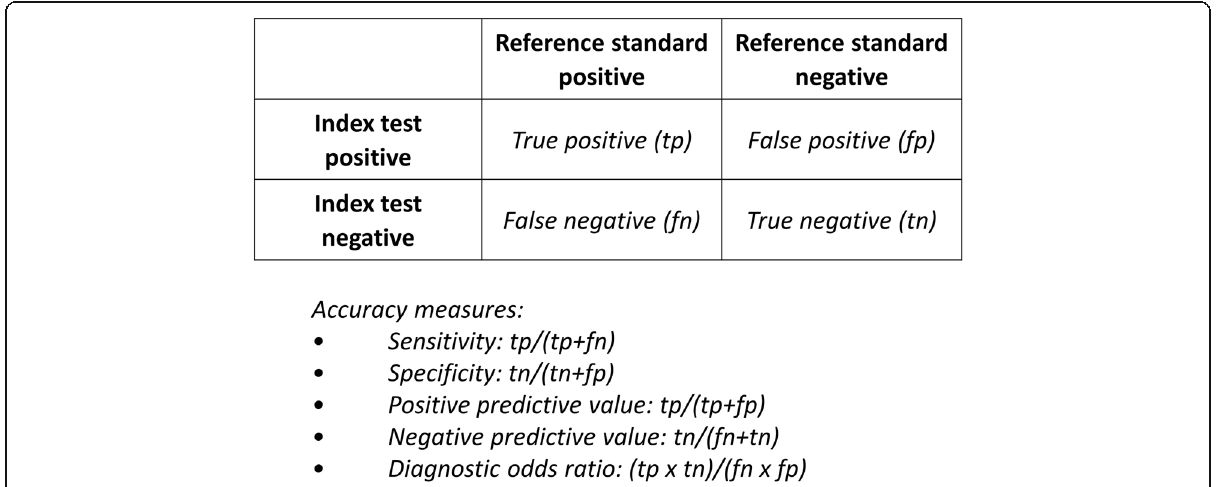
Fig. 1 Typical output of a diagnostic accuracy study: the contingency table (or “ 2 × 2 table ” )